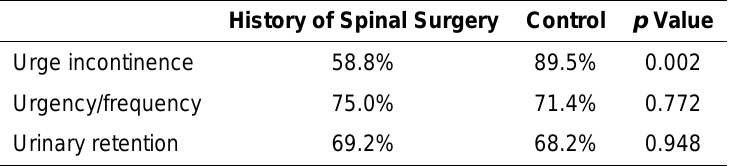
Successful Conversion